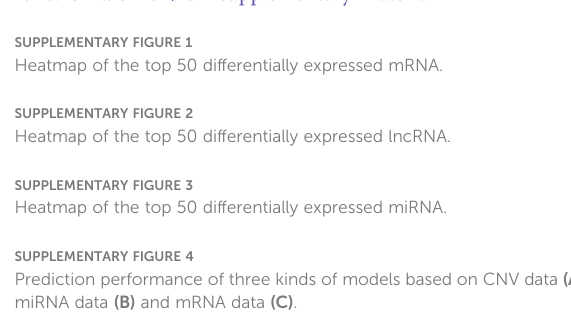
Heatmap of the top 50 differentially expressed mRNA.